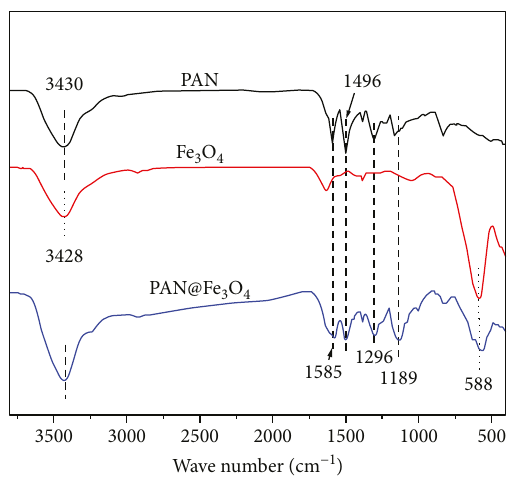
Figure 1: FTIR spectrum of PAN, Fe